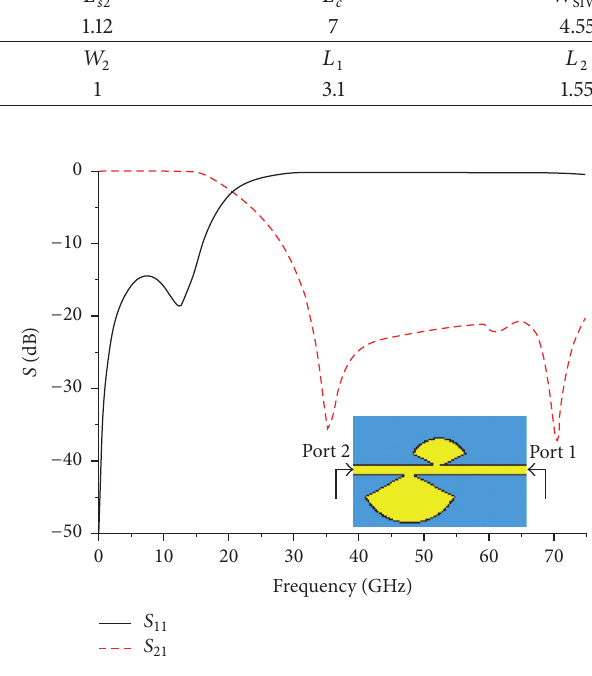
Figure 3: Simulated 𝑆 -parameters of the DC-pass